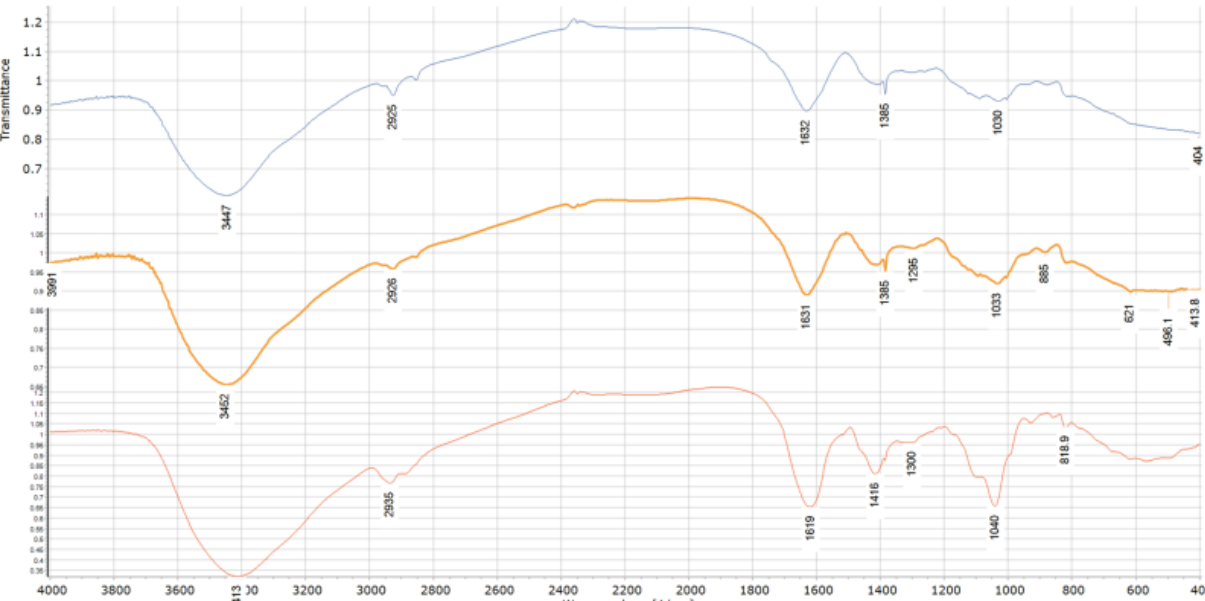
Figure 2. FT-IR spectra of investigated sample: (-) pure alginate beads ( blue line ); ( - ) activated alginate beads ( orange thick line ); and (-) immobilized alcalase-alginate beads ( orange thin line ).